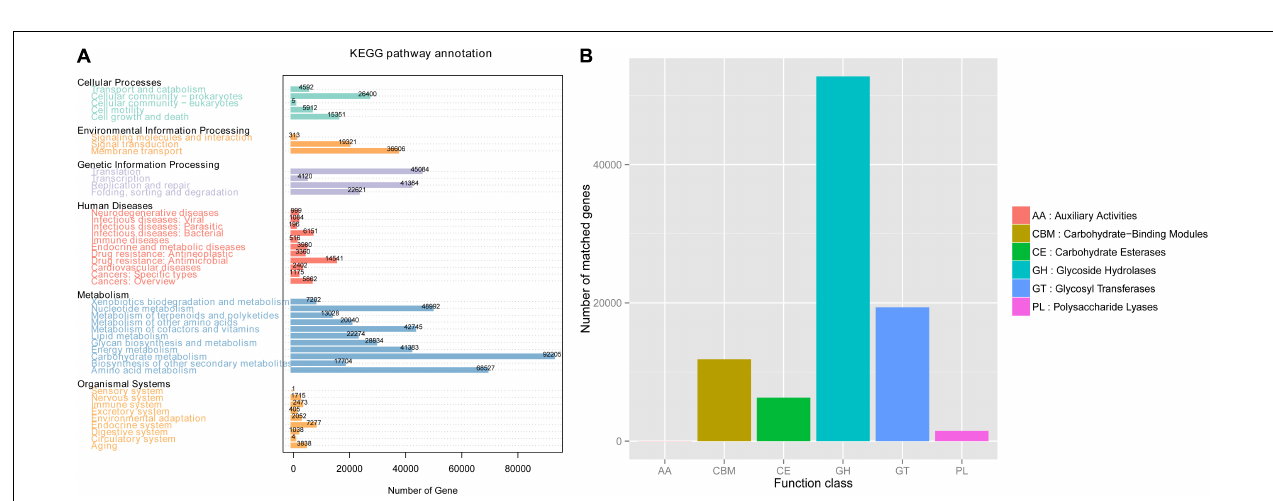
FIGURE 4 | Common functional database annotations. (A) KEGG annotations and (B) CAZy annotations.